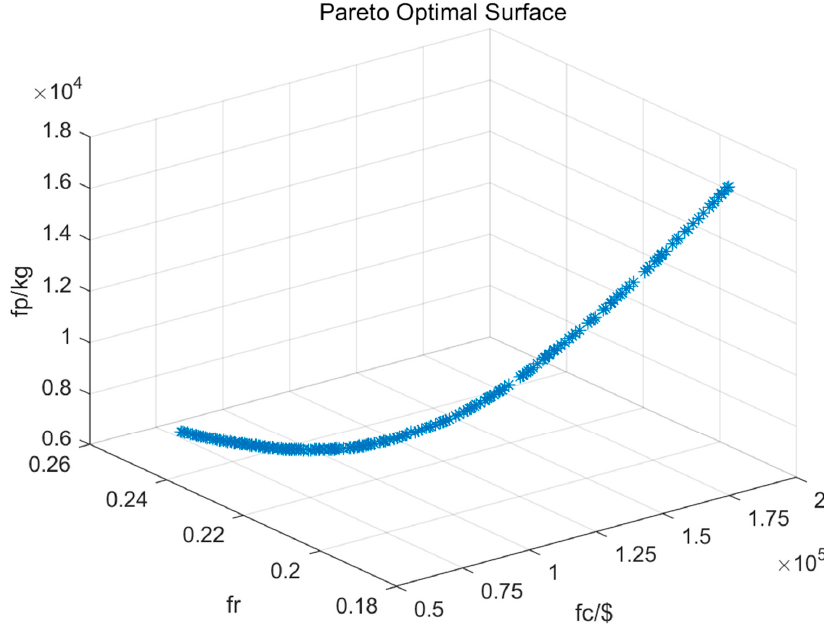
Figure 6. The three-dimensional Pareto surface of the proposed optimal strategy.